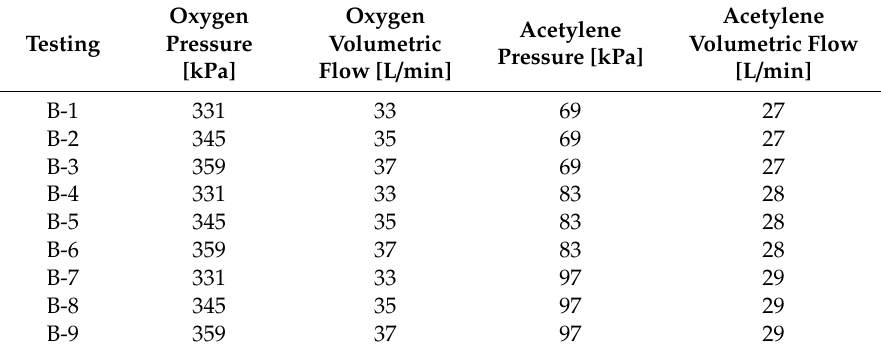
Table 1. Samples and parameters depositionof the